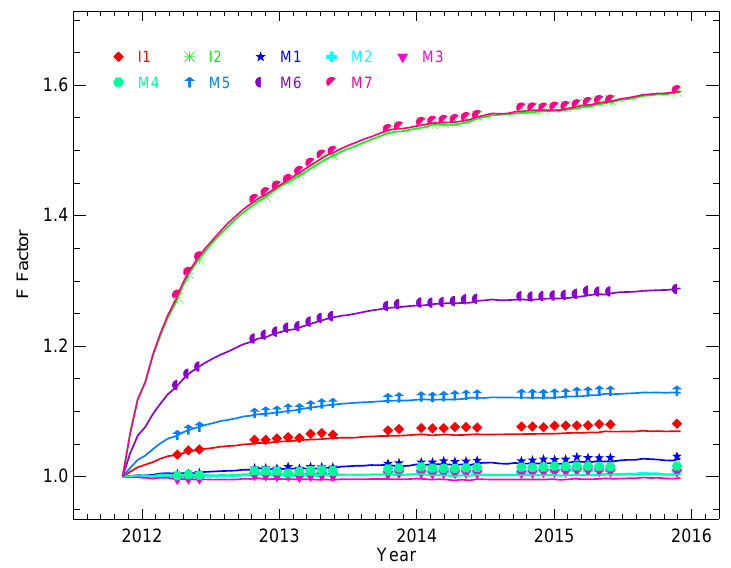
Figure 11. SNPP VIIRS RSB SD F-factors (lines) and lunar F-factors (symbols).